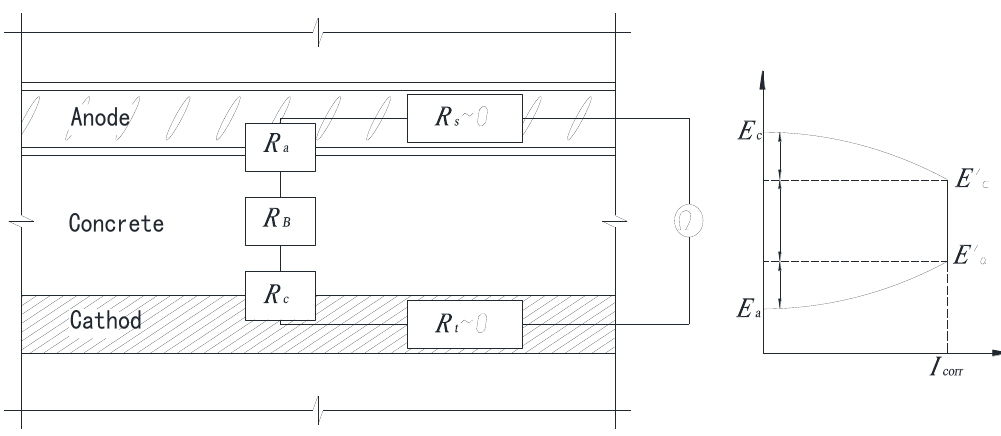
Figure 4. Equivalent circuit for corrosion closed